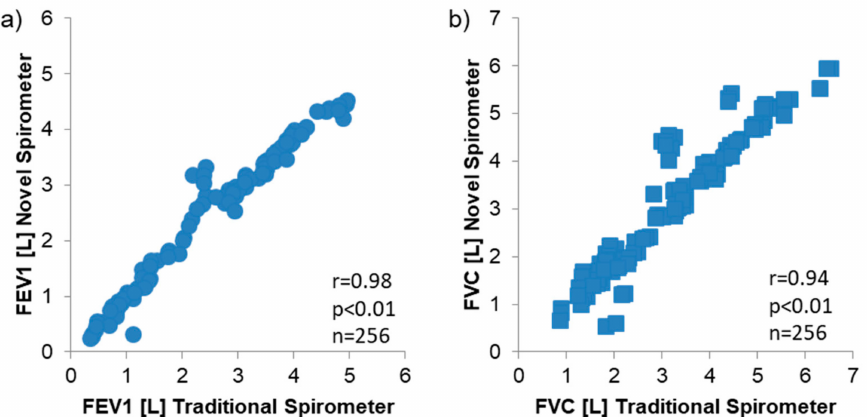
Figure 5. Correlation between values measured from the traditional and novel spirometer platform with n = 256 vital capacity maneuvers were performed on a total of 43 subjects with asthma, chronic obstructive pulmonary disease (COPD), and healthy controls, ( a ) FEV1, ( b ) FVC. Bland-Altman plots with 95% limits of agreement are shown in Figure 6. There is a slight bias for both FEV1 and FVC; however, this di ff erence is within the bounds of repeated spirometry maneuvers (150